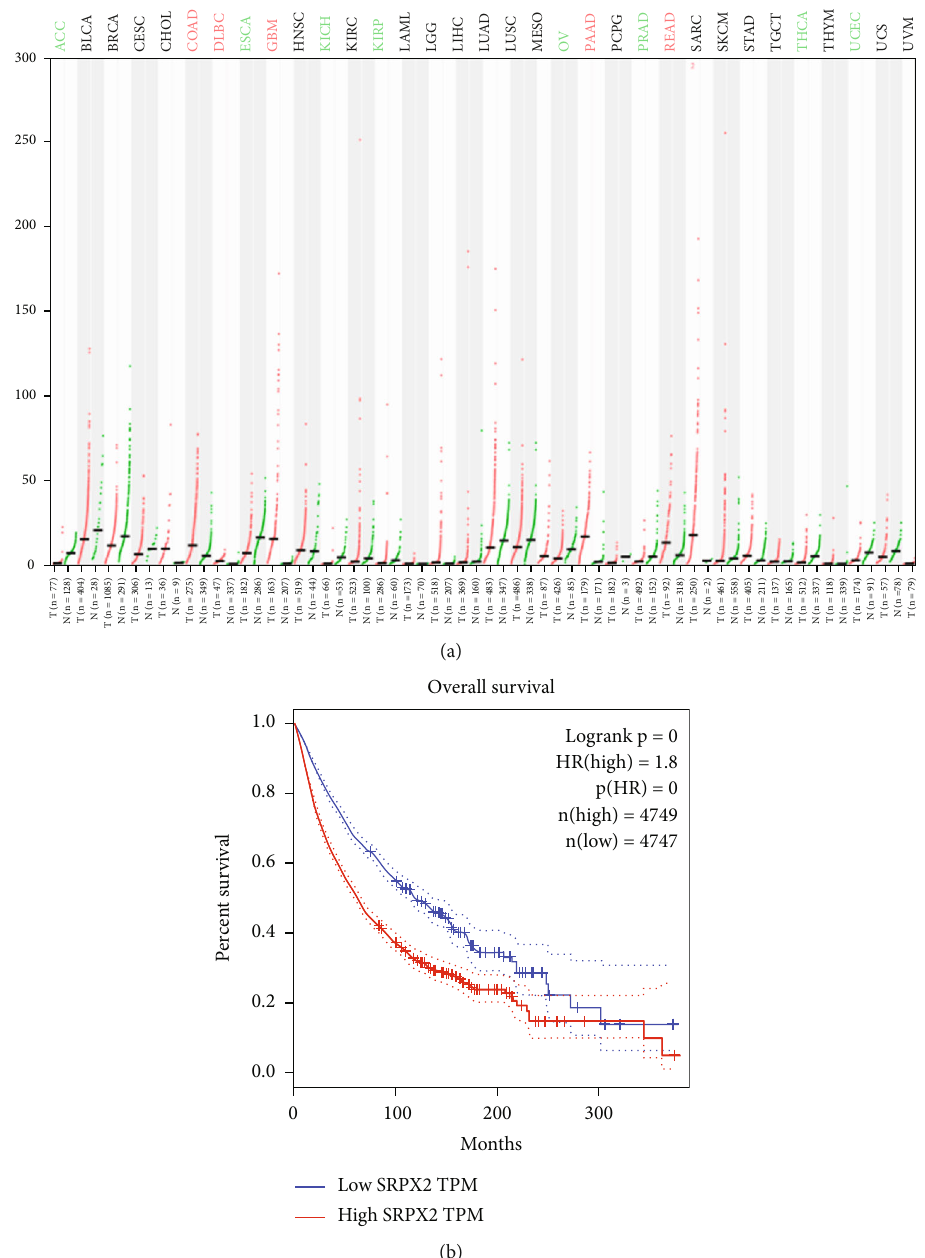
Figure 2: mRNA expression of SRPX2 and survival analysis from the TCGA and GTEx database. (a) mRNA expression of SRPX2 in 29 types of tumors. Green font represents that there is a lower expression of SRPX2 in tumor tissue than that of the appropriate normal tissue. Red font represents that there is a higher expression in tumor tissue than that of the appropriate normal tissue. Black font represents that there is no signi fi cant di ff erence in tumor tissue and the appropriate normal tissue. (b) The overall survival time of the SRPX2 high expression group ( n = 4749 ) and the SRPX2 low expression group ( n = 4747 ). ACC: adrenocortical carcinoma;